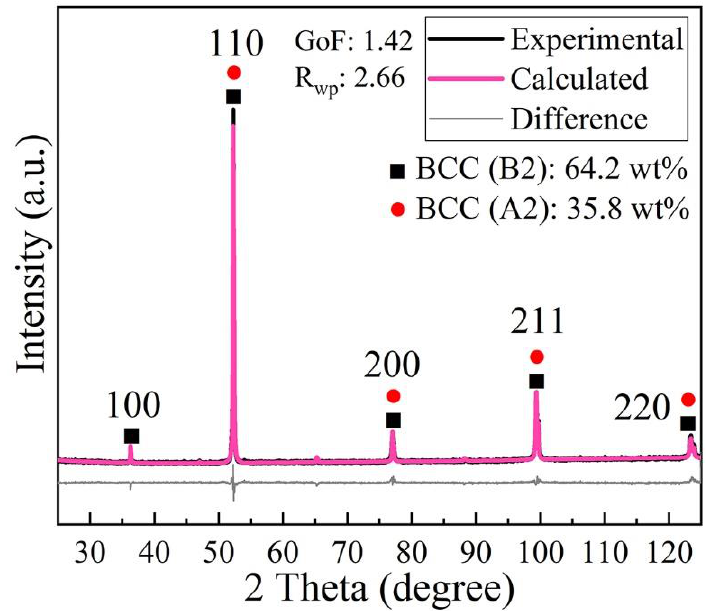
Figure 4. XRD experimental and refinement curves of the original powder.